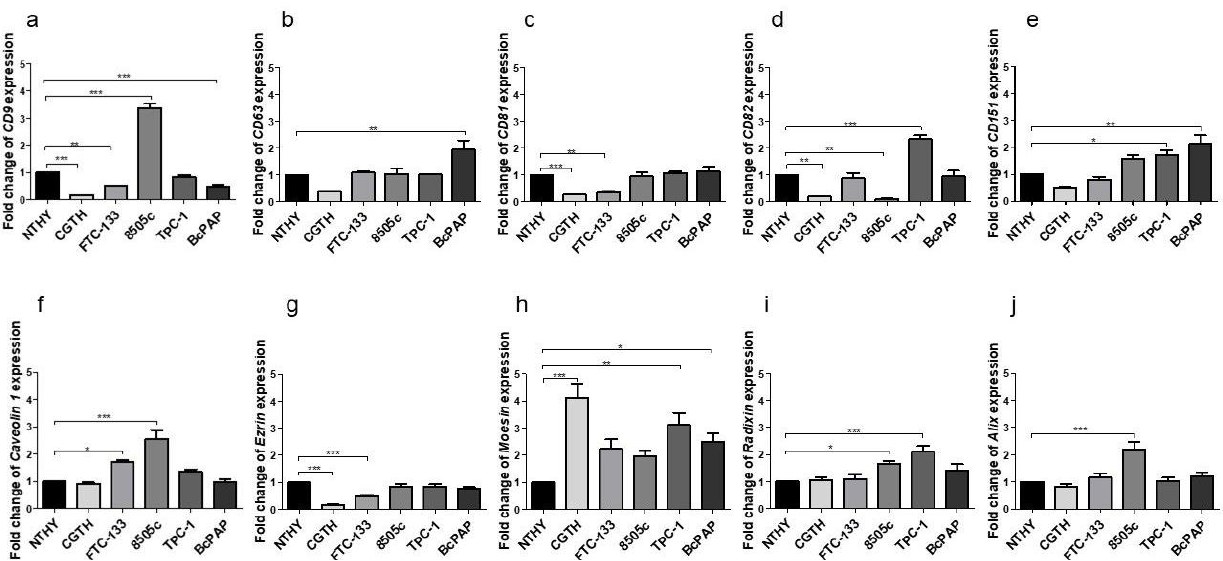
Figure 4. Relative expression of tetraspanins ( a – e ); Caveolin-1 ( f ); Ezrin ( g ); Moesin ( h ); Radixin ( i ); and Alix ( j ) in thyroid cell lines. Data are reported as means with standard deviation (±SEM). *: p < 0.05; ** p < 0.01; ***: p < 0.001.